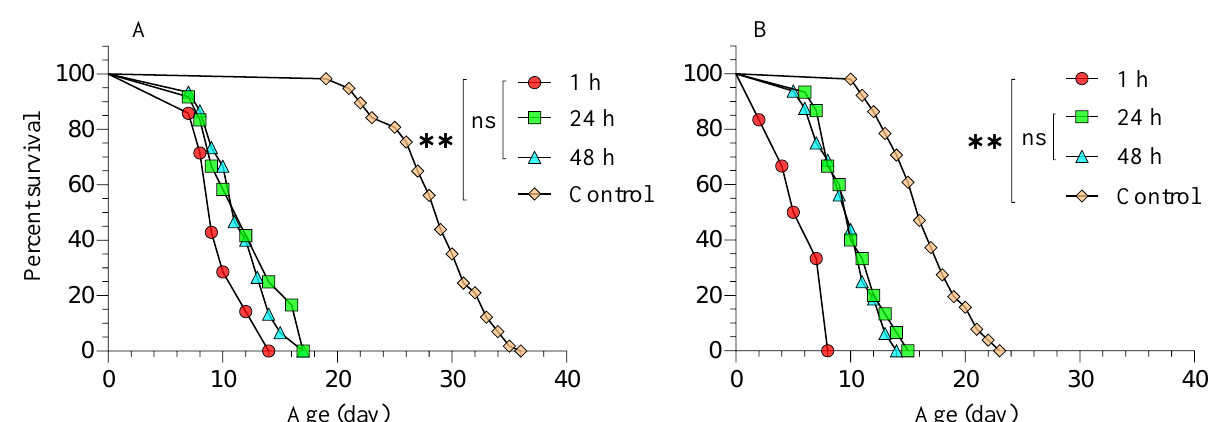
Figure 4. Survival rate for females ( A ) and males ( B ). Survival curves of Tamarixia radiata by log-rank analysis were generated where Diaphorina citri were first treated with Beauveria bassiana (BB-12) and subsequently exposed to Tamarixia radiata (Females n = 7, 12, 15 and 57 at 1 h, 24 h, 48 h and control, respectively) (Males n = 6, 15, 16 and 50 at 1, 24, 48 h and control, respectively). (** p < 0.001).